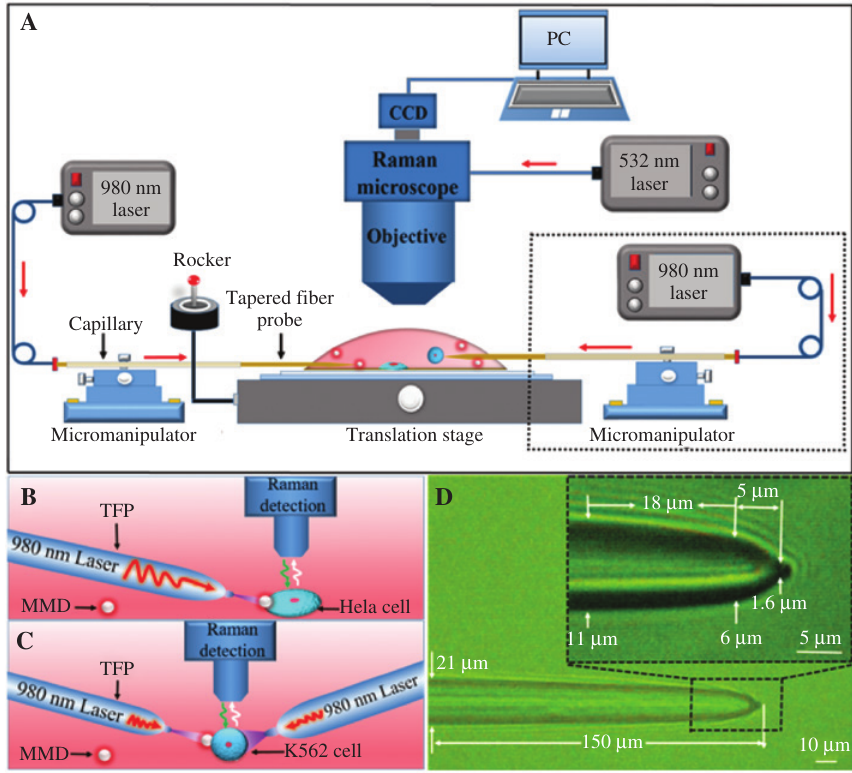
Figure 1: Schematic of the experiments. (A) Schematic of the experimental setup. The red arrows indicate the direction of the input laser beam. (B) Schematic of targeted drug delivery and Raman detection for a single HeLa cell. The red arrow indicates the input 980 nm laser beam used for trapping MMD, and the green and white arrows indicate a 532 nm excitation laser beam and the Raman scattered light, respectively. (C) Schematic of targeted drug delivery and Raman detection for a single K562 cell. Another TFP was added to trap the K562 cell. The red arrow indicates the input 980 nm laser beam used for trapping the MMD or K562 cell, and the green and white arrows indicate a 532 nm excitation laser beam and the Raman scattered light, respectively. (D) Optical microscope image of the TFP used in